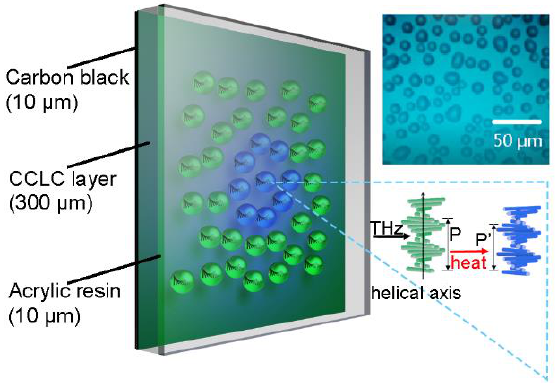
Figure 1. Schematic and working principle of the capsulized cholesteric liquid crystal film (CCLCF). The inset shows a micrograph of the CCLCF, which is produced with a color 3D laser scanning microscope (VK-8710, KEYENCE, Osaka, Japan).